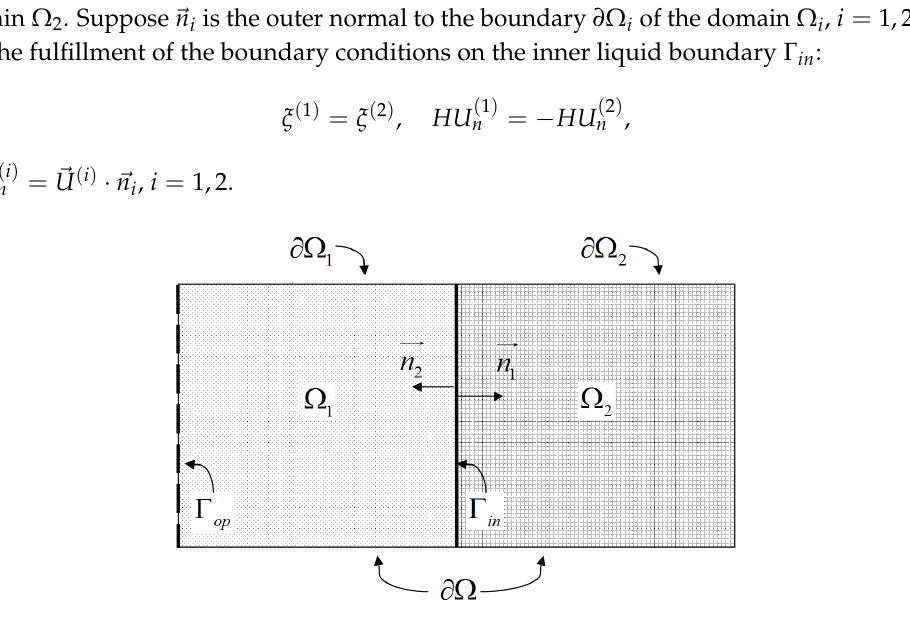
Figure 1. Domain with “inner” Γ in and “outer” Γ op liquid